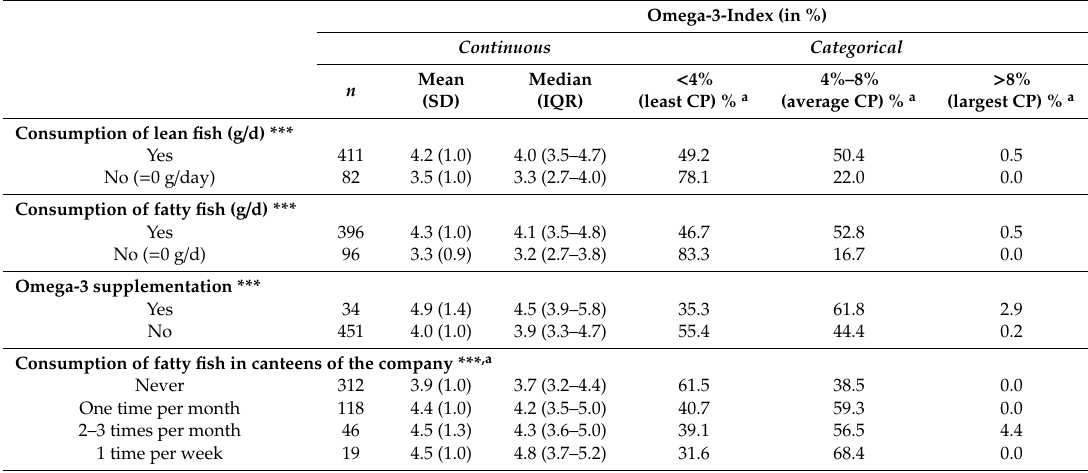
Table 4. Omega-3 index (categorical and continuous) stratified according to consumption of lean and fatty fish, diet, supplementation and consumption of fish in the canteens ( n =